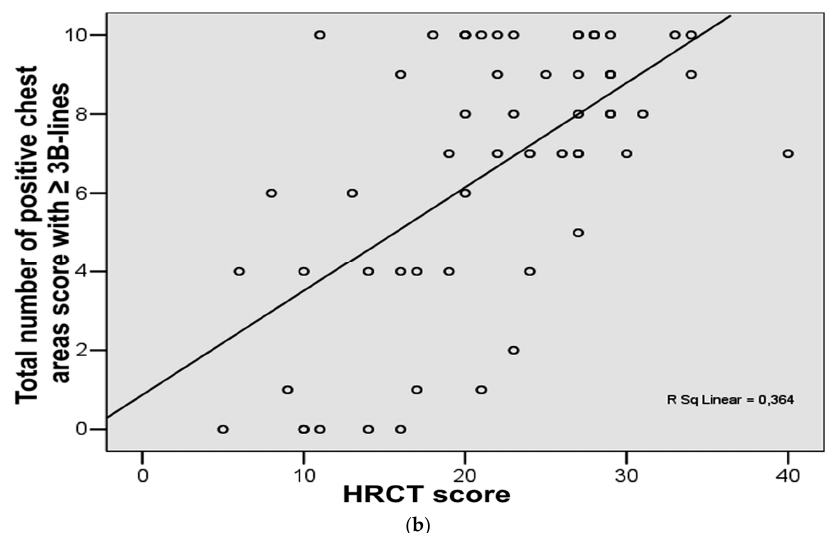
Figure 2. ( a ) Correlation between chest high-resolution computed tomography (HRCT) score and total number of B-lines score in the study group. ( b ) Correlation between chest high-resolution computed tomography (HRCT) score and total number of positive chest areas score with ≥ 3 B-lines in the study group. From the 58 patients consecutively diagnosed with ILD, 30 (51.7%) were diagnosed with IPF, 7 (12.1%) with NSIP, 9 (15.5%), with pulmonary sarcoidosis, and 12 (20.7%) patients were diagnosed with CTD including 5 (8.62%) patients with rheumathoid arthritis, 5 (8.62%) patients with systemic sclerosis (SSc), 1 (1.72%) patient with systemic lupus erythematosus, and 1 (1.72%) with ankylosing spondylitis. Age was significantly different between the three groups ( p < 0.001) (Table 1). In the first group (UIP pattern), the patients were significantly older than the others. Table 1. Comparison between group one (usual interstitial pneumonia, UIP), group two (nonspecific interstitial pneumonia, NSIP), and group three (micronodules or other radiological interstitial abnormalities).